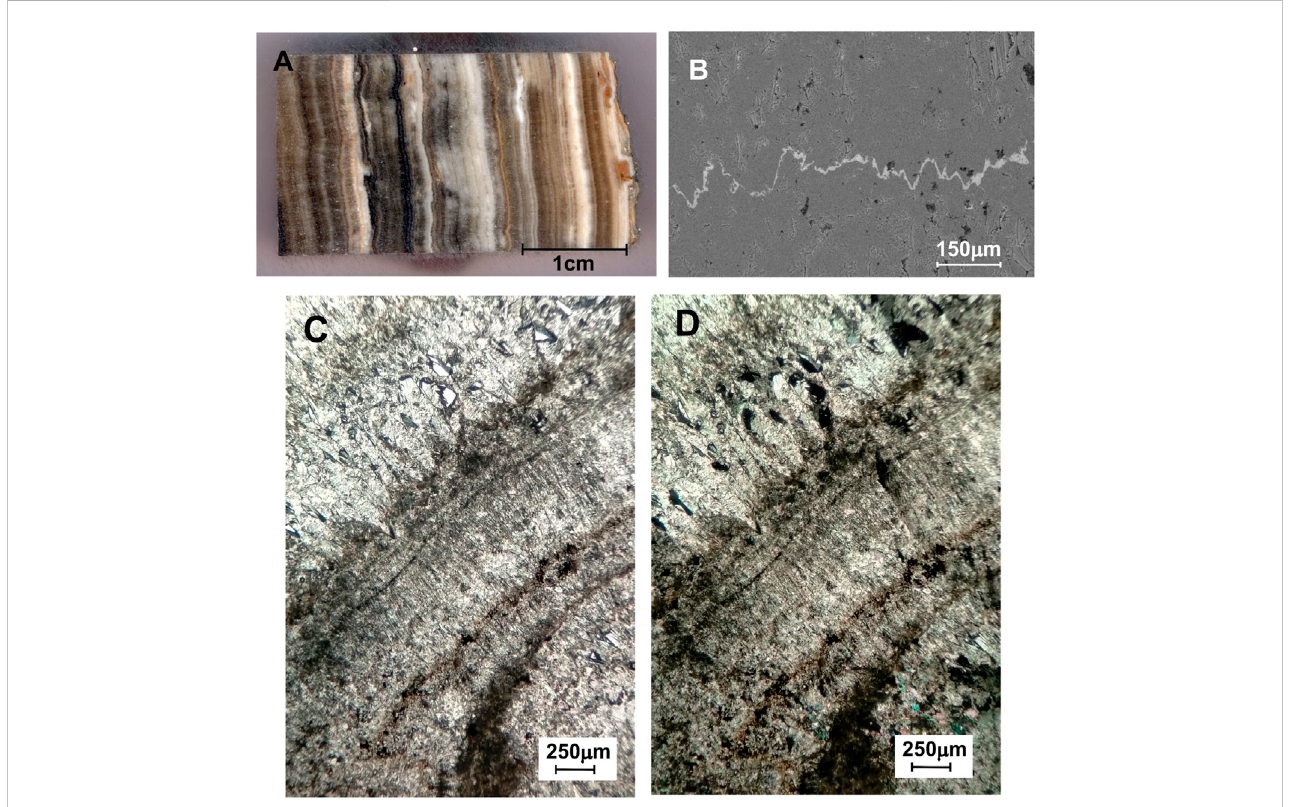
FIGURE 7 Crystalline crust travertine. (A) Polished slab with different coloured crystalline travertine and parallel-banded growth. (B) SEM image showing large calcite crystals and irregular oxides bands (C and D) Thin section with parallel and crossed nicols respectively. Fanshaped crystals alternating with isometric crystals forming crystalline crust